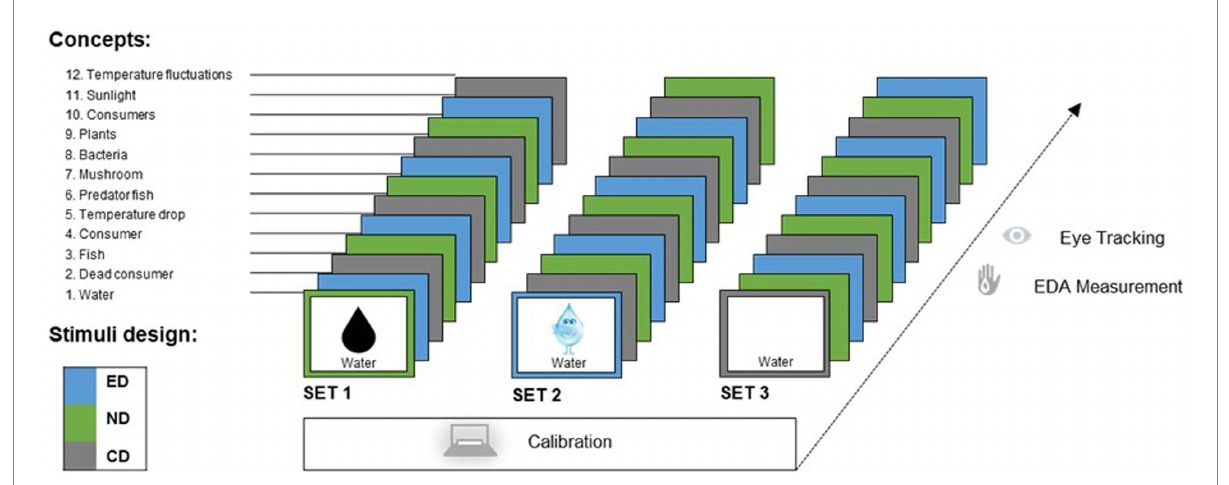
FIGURE 3 Research design and procedure. Students were assigned to one of three sets of stimuli. The 12 concepts (left) were displayed, with their design varying from one stimulus to the next (emotional design [ED], neutral design [ND], and control design [CD]).